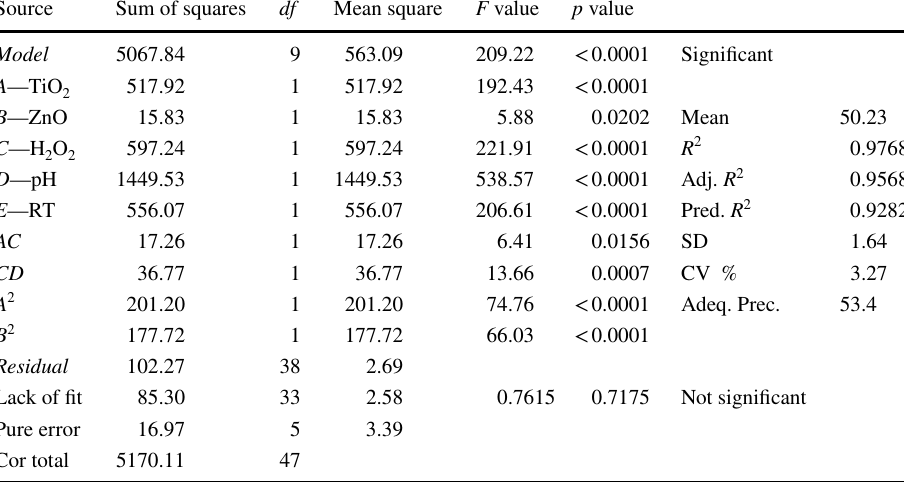
(ANOVA) results of second- order models for TOC removal